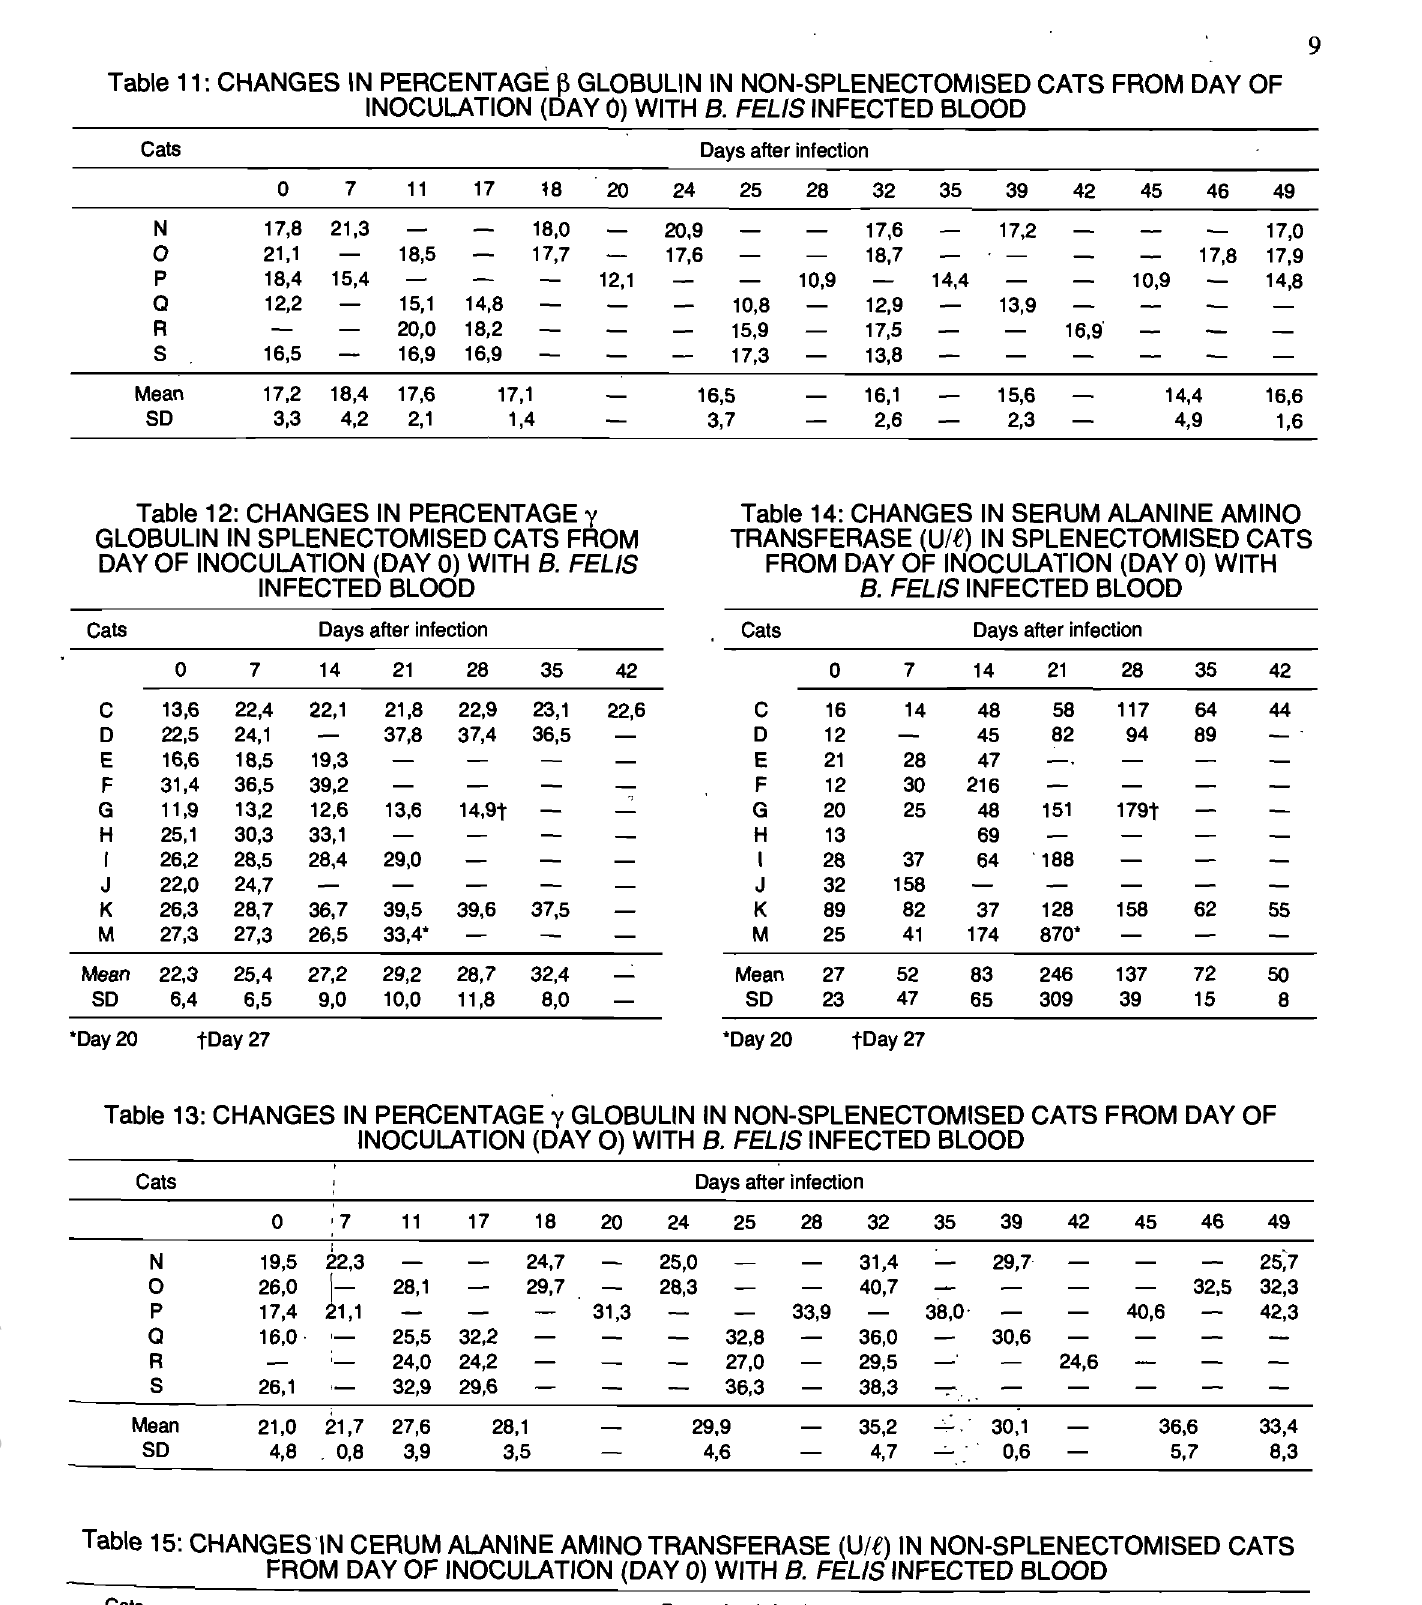
Table 11: CHANGES IN PERCENTAGE ~ GLOBULIN IN NON-SPLENECTOMISED CATS FROM DAY OF INOCULATION (DAY 0) WITH B. FELIS INFECTED BLOOD Cats